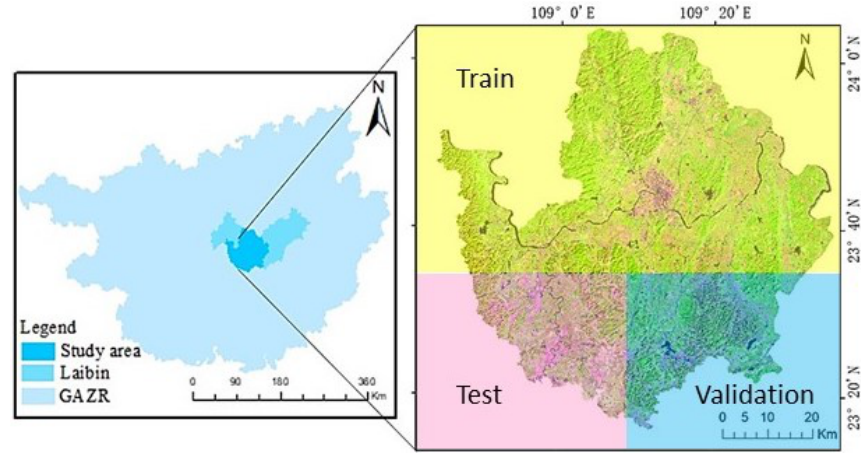
Figure 1. Location of the study area and Landsat 8 remote sensing images.